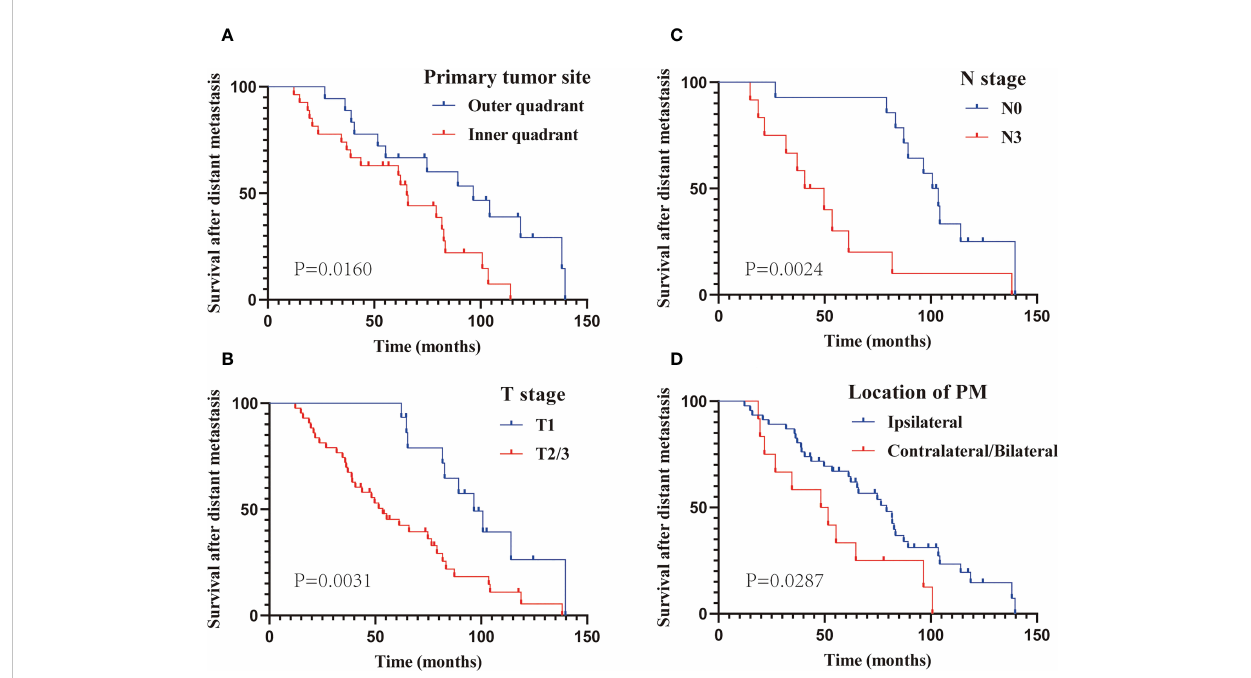
FIGURE 4 The Kaplan – Meier curve analysis of M-OS in subgroups based on multivariate analysis. Subgroup of primary site (A) ; T stage (B) ; N stage (C) ; location of PM (D) . PM, Pleural metastasis.